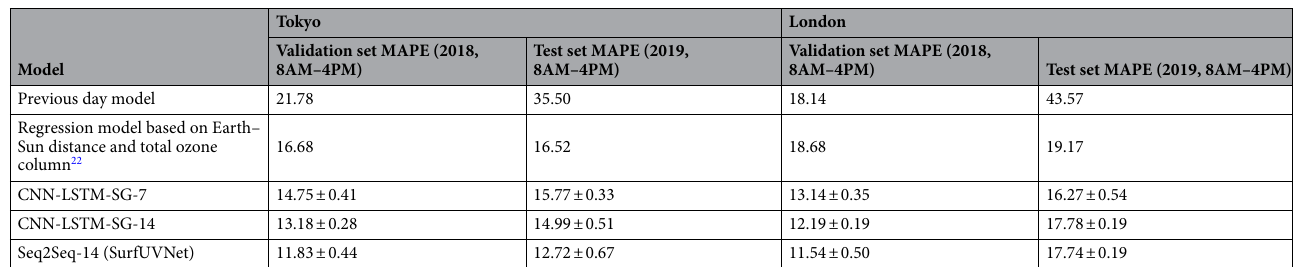
Table 2. Mean absolute percentage errors (MAPE) of the next-day antipsoriatic irradiance forecasting produced by SurfUVNet and other models on the ERA5 Tokyo and London